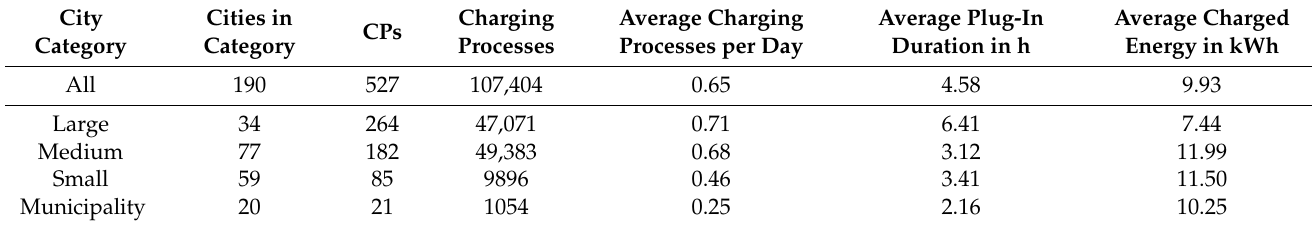
Table 3. Characteristics of the processed data classified by